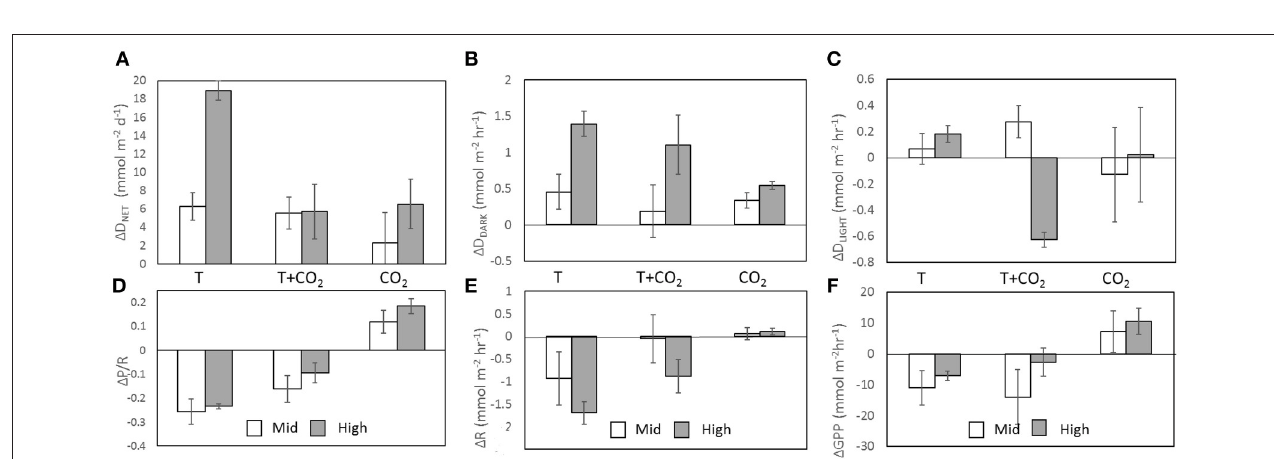
FIGURE 3 | Correlation between 1 T and 1 R (A) and 1 T and 1 GPP (B) from incubation T. 1 T is the difference in night (A) and day (B) temperature of each temperature treatment chamber from the average temperature of control chambers ( n = 3). 1 GPP and 1 R are the average differences between the temperature treatment chambers compared to the average of control chambers.